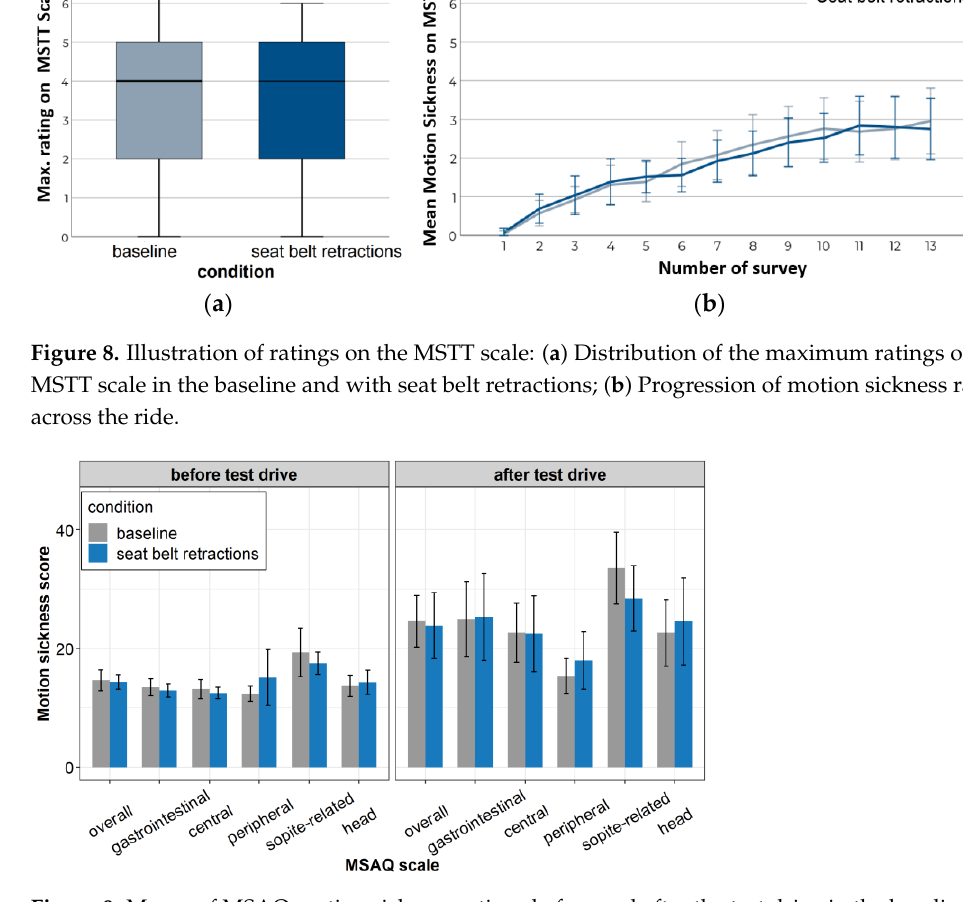
Figure 8. Illustration of ratings on the MSTT scale: ( a ) Distribution of the maximum ratings on the MSTT scale in the baseline and with seat belt retractions; ( b ) Progression of motion sickness rating across the ride.